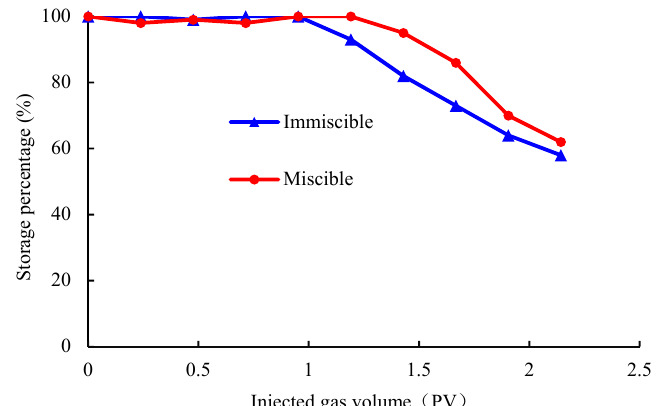
Figure 7. Relationship between injection mode and storage factor.